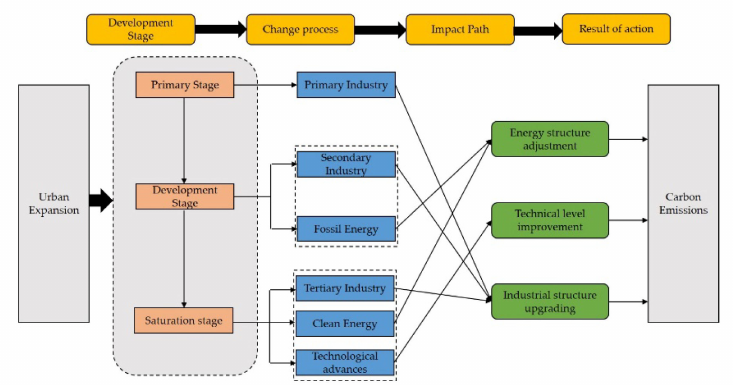
Figure 4. Urban expansion and carbon emission impact